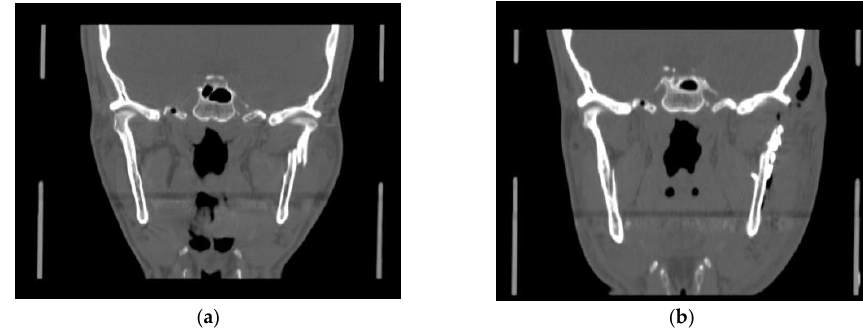
Figure 1. ( a ) Pre-operatory panoramic X-ray; ( b ) pre-operatory computerized tomography scan (CT scan); ( c ) pre-operatory volumetric CT scan; ( d ) intra-operatory view; ( e ) post-operatory coronal CT scan; and ( f ) post-operatory volumetric CT scan of patient #1.